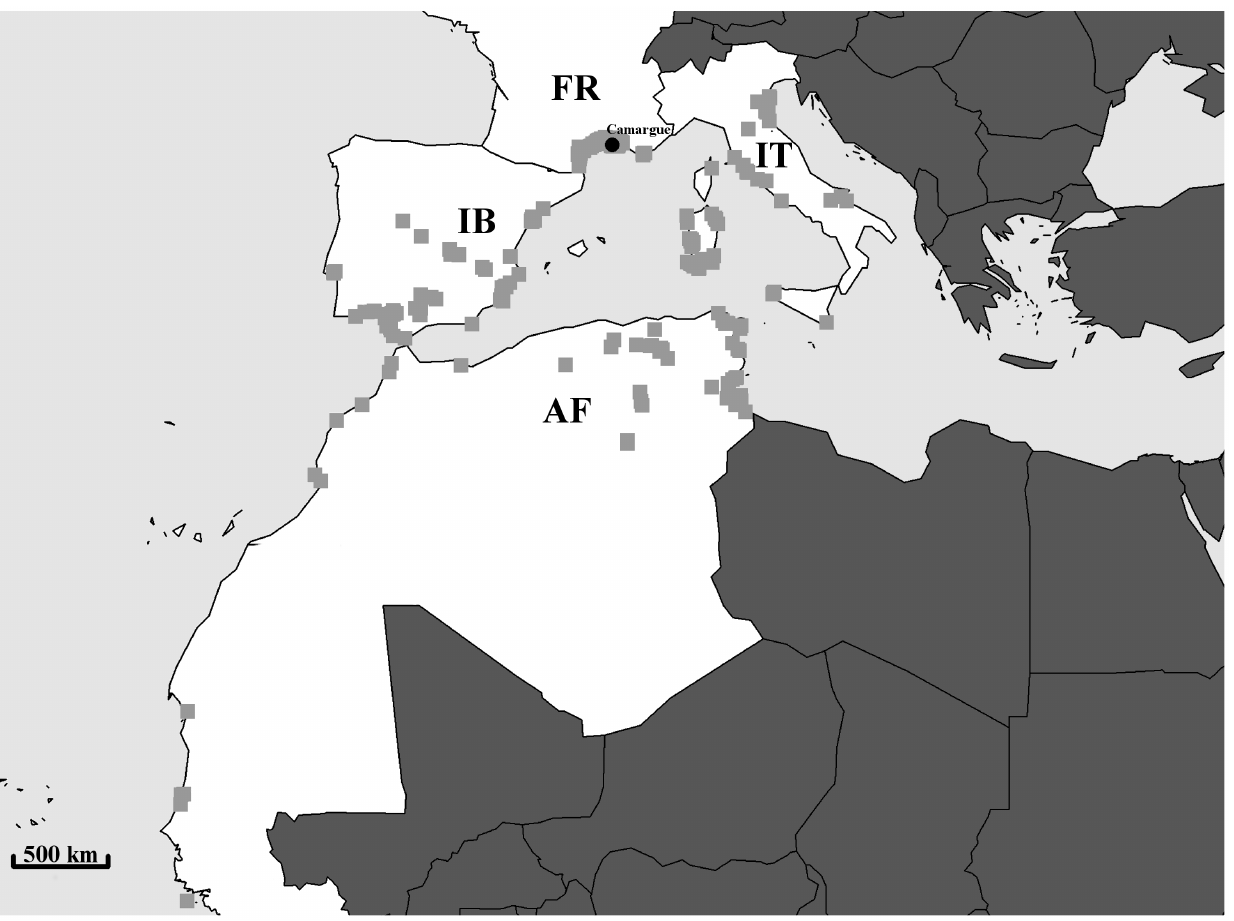
Figure 1. Map showing the natal site in Camargue, southern France and resightings locations of greater flamingos from summer 1995 to winter 2010 in the Mediterranean and west Africa which are represented by the grey squares. Also shown are the geographical regions used in this study: southern France (FR); Italy (IT); Iberian Peninsula (IB); and, north and west Africa (AF).